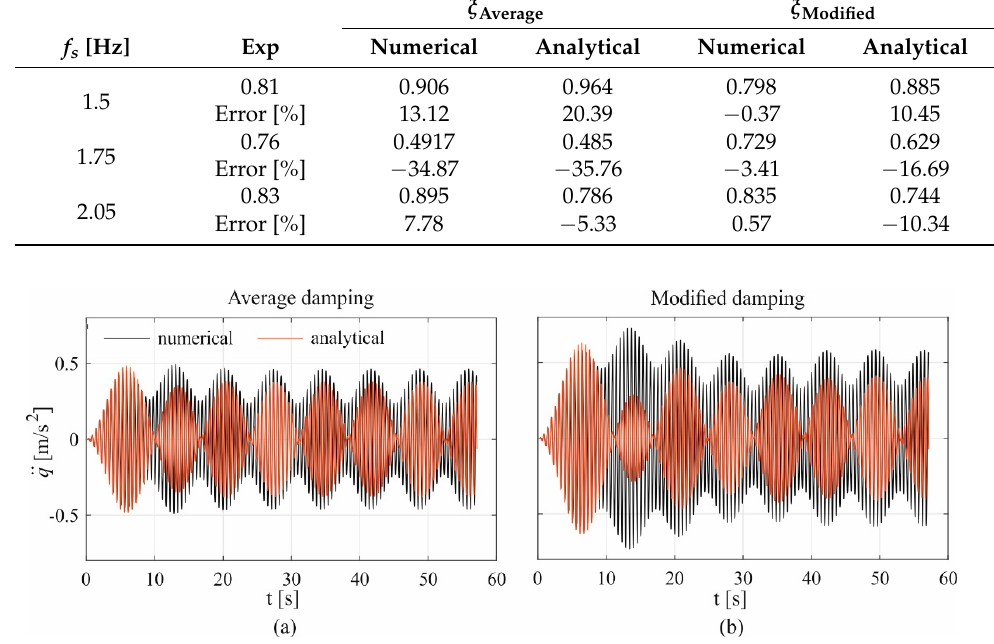
Table 9. Comparison of peak acceleration responses [m/s 2 ] obtained through experimental, numeri- cal, and analytical approaches for a single pedestrian crossing at different step frequencies. ξ Average ξ Modified